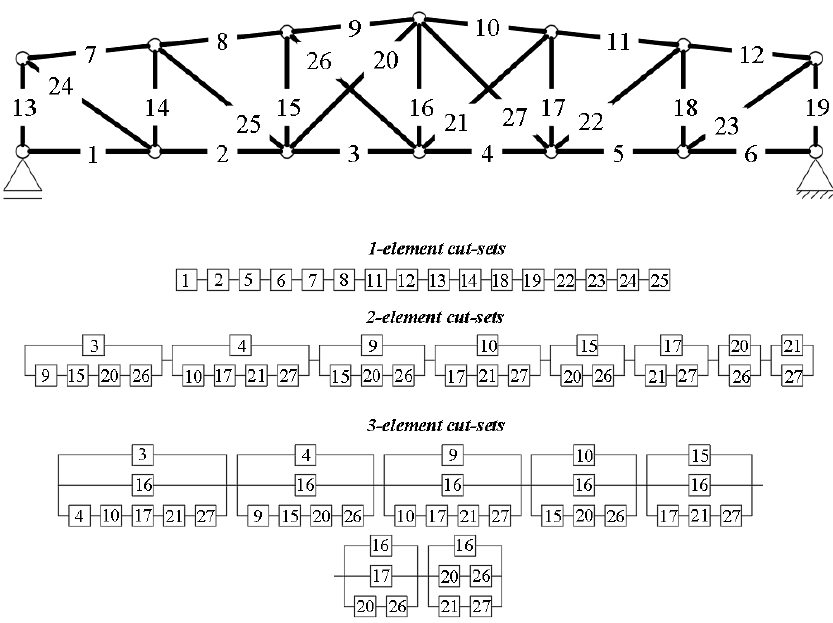
The 3rd change of the static scheme (statically determinate structure):